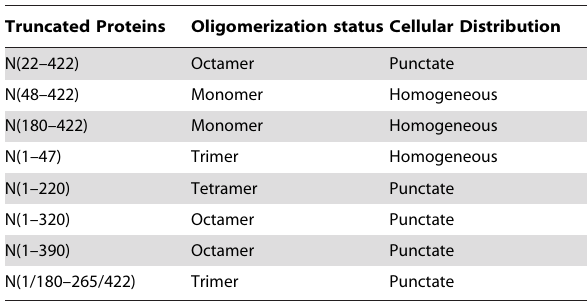
Table 1. Comparison of oligomerization status and cellular distribution of different truncated mutants of CHPV